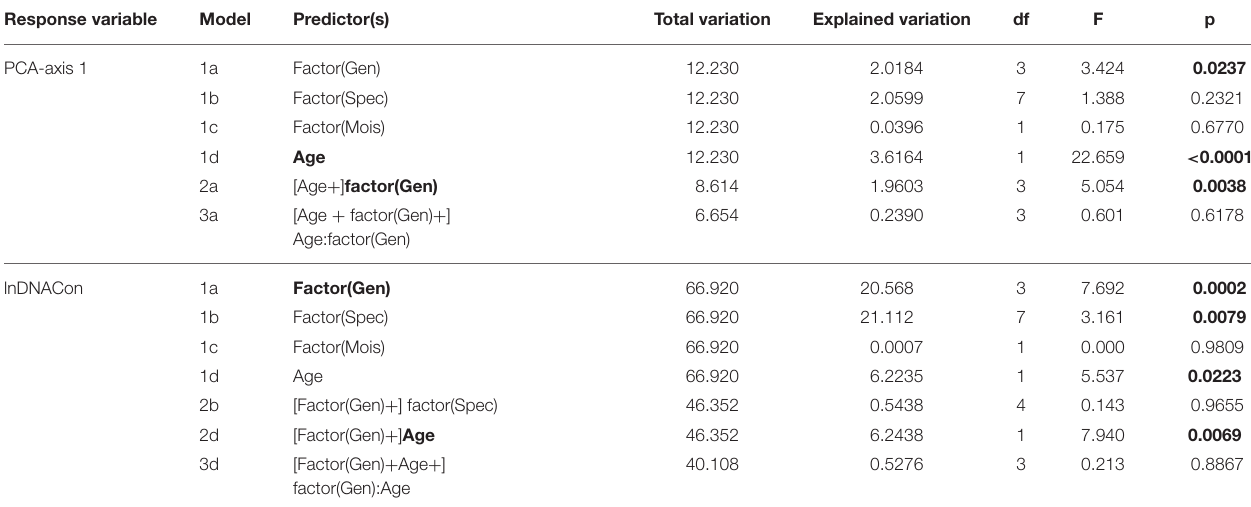
TABLE 4 | GLM modeling of DNA quality variables “PCA-axis 1” [a compositive variable that expresses relative sequence length (SeqLFr), number of reads (NoReads) and average read coverage (CovAvg)] and the logarithm of tissue DNA concentration (“lnDNACon”) as a function of the predictor variables genus (Gen), species in genus (Spec), moisture (Mois) and tissue age